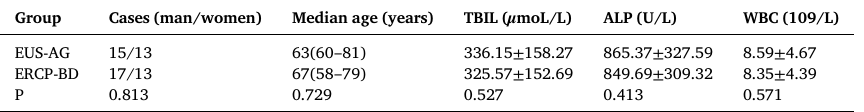
Table 1 Comparison of general data between the two